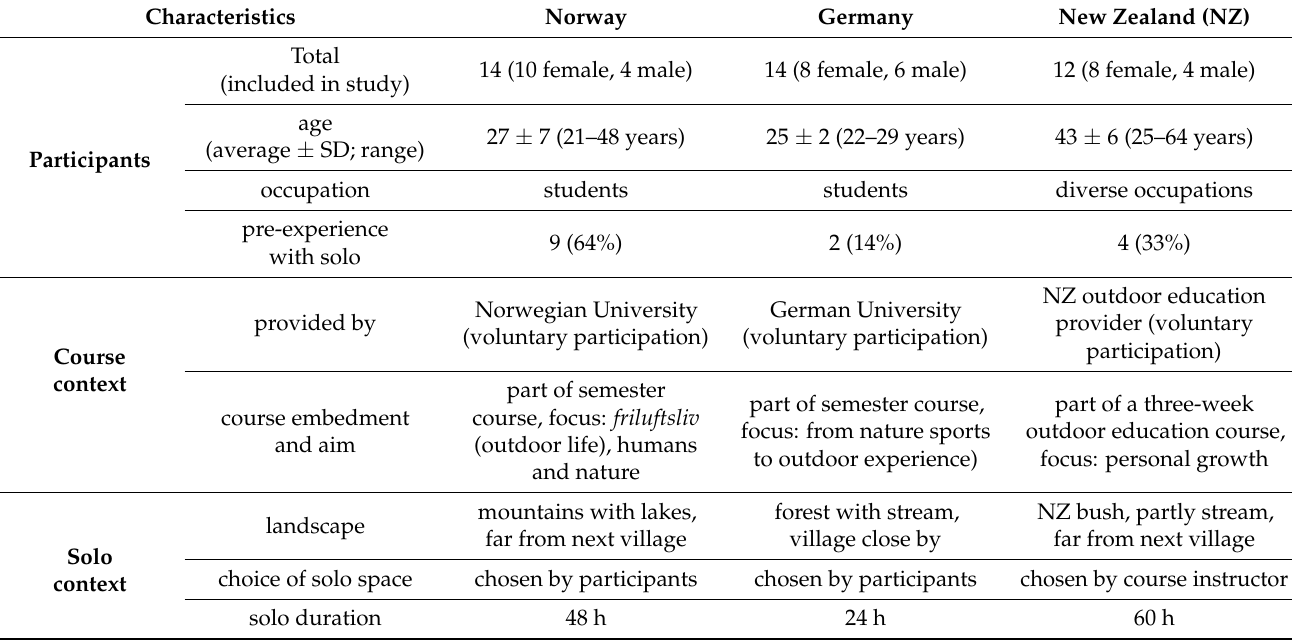
Table 1. Participants and solo context characteristics for national samples: Norway, Germany, and New Zealand.